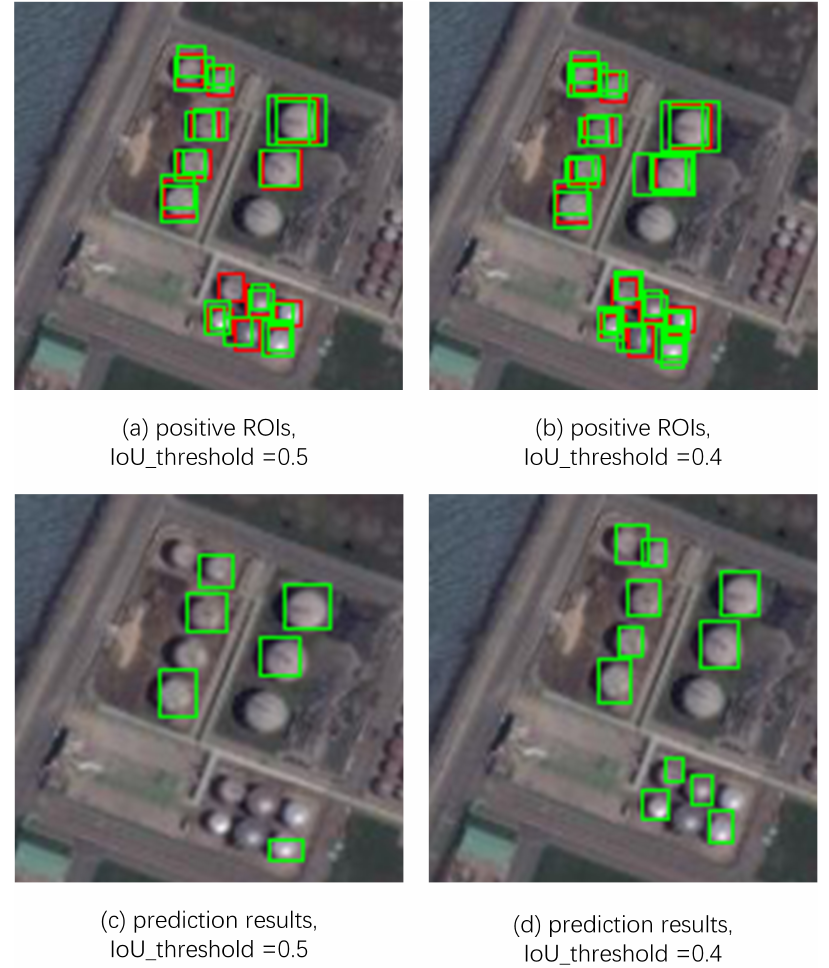
Figure 7. The positive ROIs and the prediction results when we used different IoU threshold to train the detection framework. ( a , b ) shows the positive ROIs corresponding to small objects participating in network training when the IoU threshold is set to 0.5 and 0.4, respectively, and ( c , d ) shows the prediction results of the baseline network and the network which used more dilated convolutions and a lower IoU threshold. The GT box is represented by a red rectangle, and the positive ROIs corresponding to the GT box or detection results are represented by green rectangles. It can be seen that when the IoU threshold is set to 0.4, there are more small objects involved in network training and the test result gets a higher recall